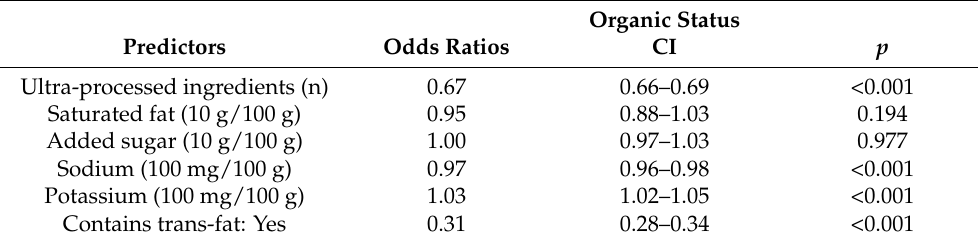
Table A3. Results from mixed logistic regression model of 8240 organic and 72,205 conventional products whereby missing nutrient values were assumed to be zero. This model included the parameter “ultra-processed ingredients”.